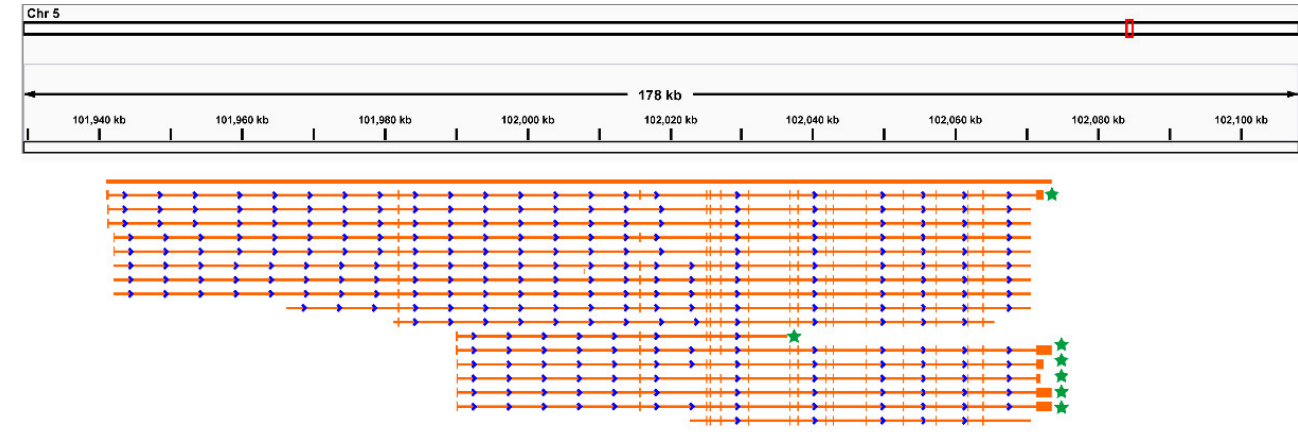
Figure 2. Identified isoforms in CAST . The numbers at the top of the figure represent the genome coordinates. Each yellow horizontal line represents an isoform. Each yellow vertical dash represents an exon. Stars on the right denote the novel isoforms identified in the current study. Blue arrows denote the direction of transcription. Stars in right denote novel isoforms.